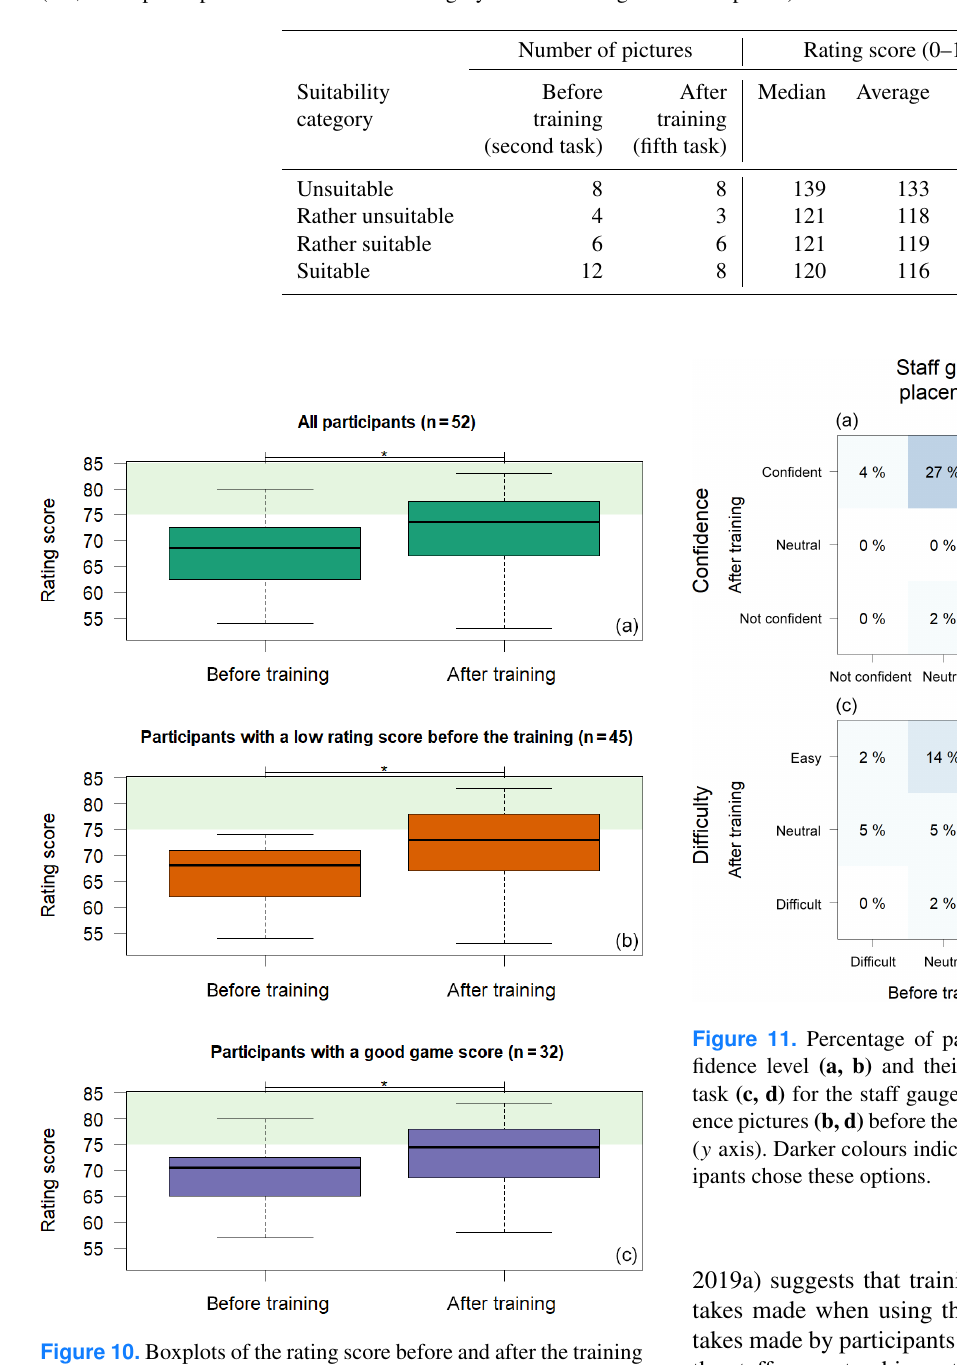
Table 2. Number of pictures to be rated before and after the training per suitability category (as determined prior to the study by the experts) and the median, average and range in rating scores for the pictures in each category. Each picture can receive a maximum rating of 156 points (i.e., all 52 participants chose the correct category and therefore gained three points).